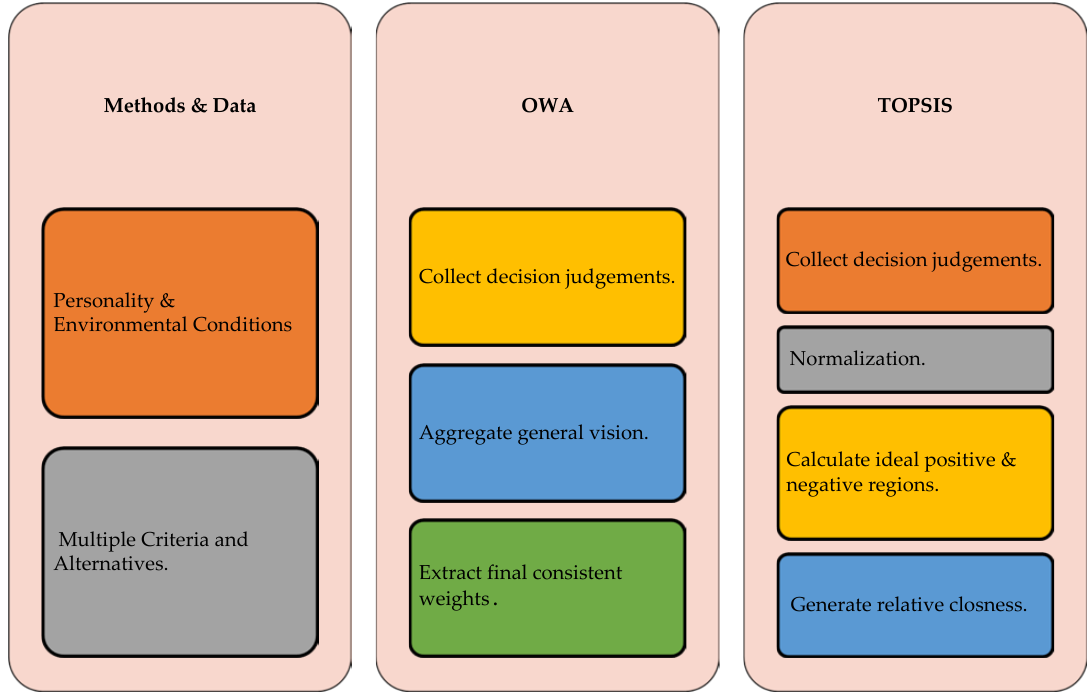
Figure 2. Overview of the proposed method.